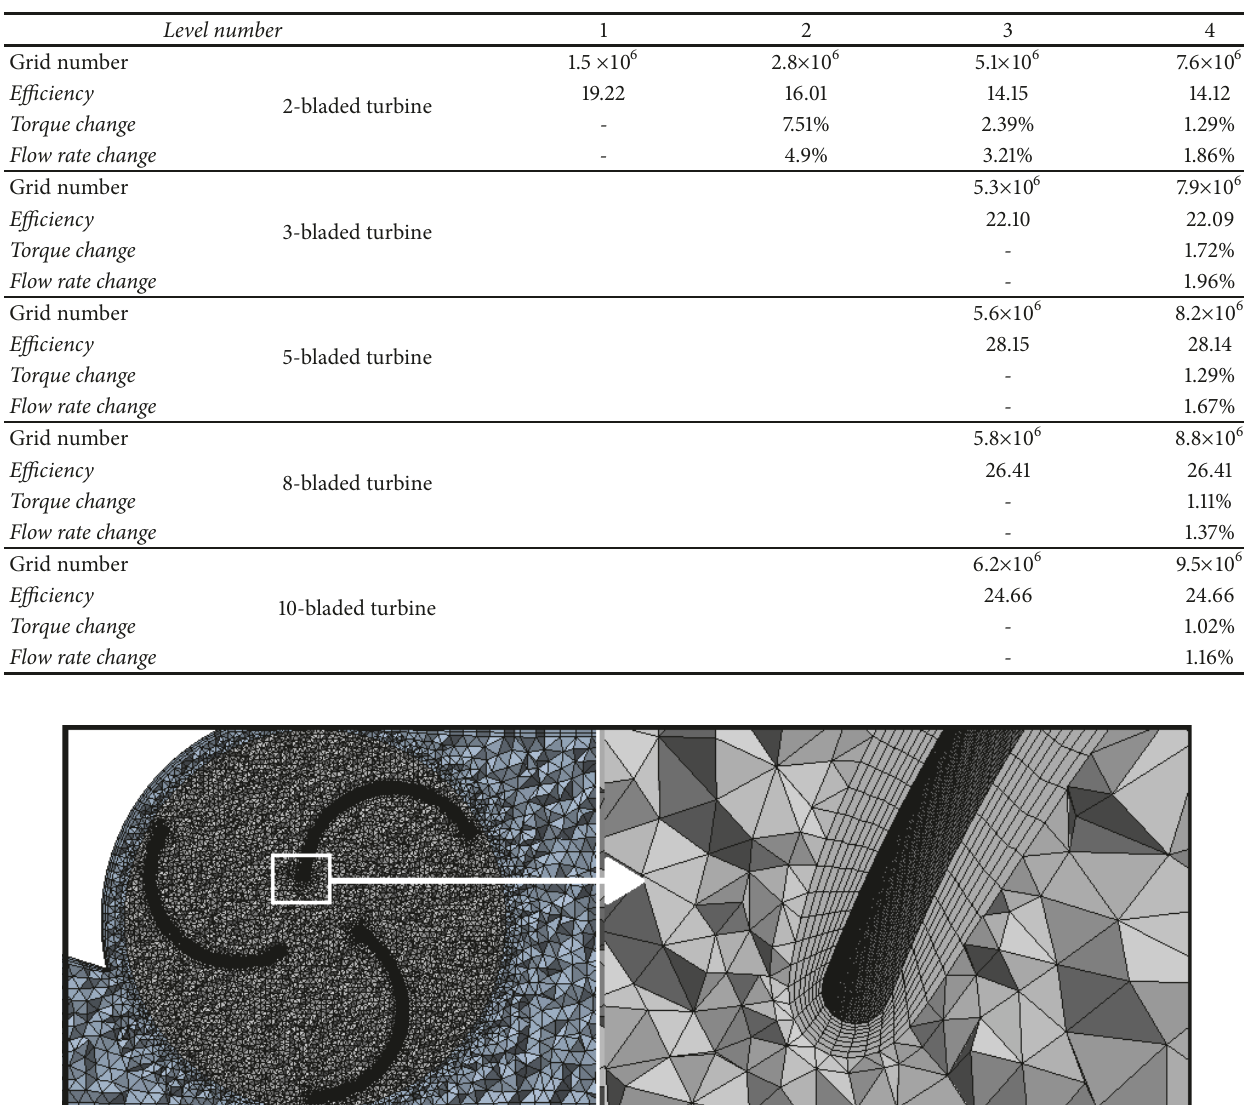
Table 3: Grid number vs. efficiency for all turbines.